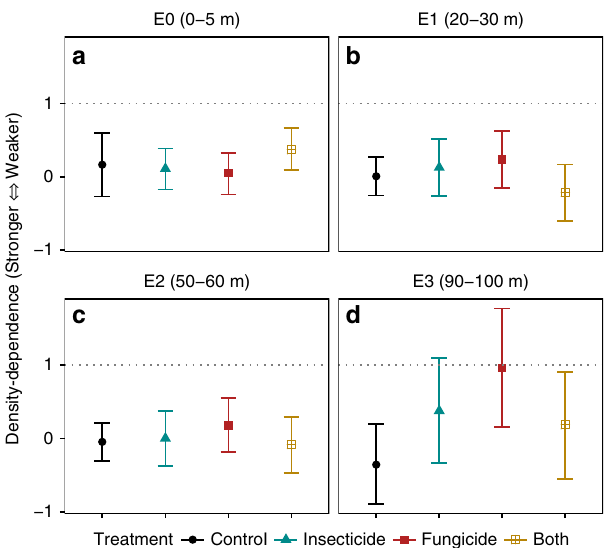
Fig. 4 Change in mean strength of CNDD with pesticide treatment at increasing distances from the forest edge. CNDD was estimated at: a 0 – 5 m (E0), b 20 – 30 m (E1), c 50 – 60 m (E2), and d E3 (90 – 100 m) from the forest edge. Points represent estimated strength of CNDD ( N = 146 per treatment) and bars provide 95% Bayesian credible intervals for parameters estimated using generalized linear mixed-effects models in a hierarchical Bayesian framework. Dotted line represents no CNDD (slope of density-dependent seed-to-seedling transition = 1). The degree of overlap in credible intervals is an indication of the strength of difference between treatments — lesser overlap suggesting stronger differences. Separate slopes were estimated per species and group-level intercepts per species and station